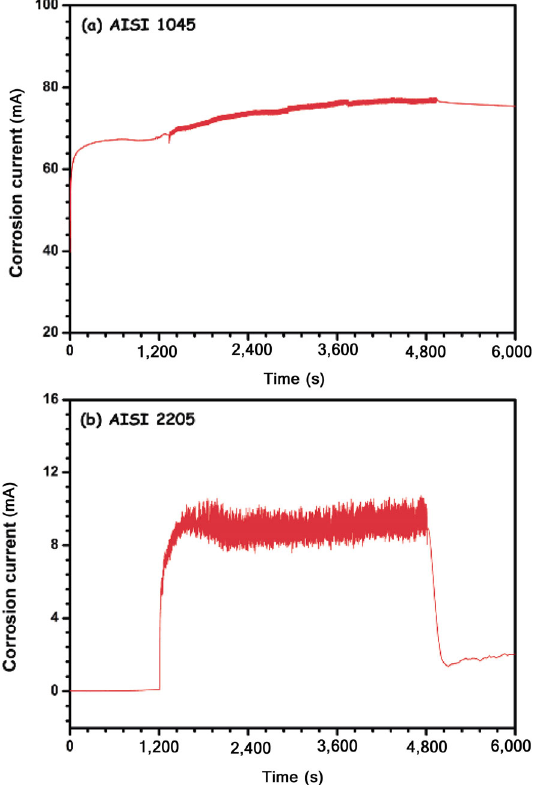
Fig. 5 Evolution of the current recorded before, during, and after sliding at an applied potential of +0.2 V for (a) AISI 1045 and (b) AISI